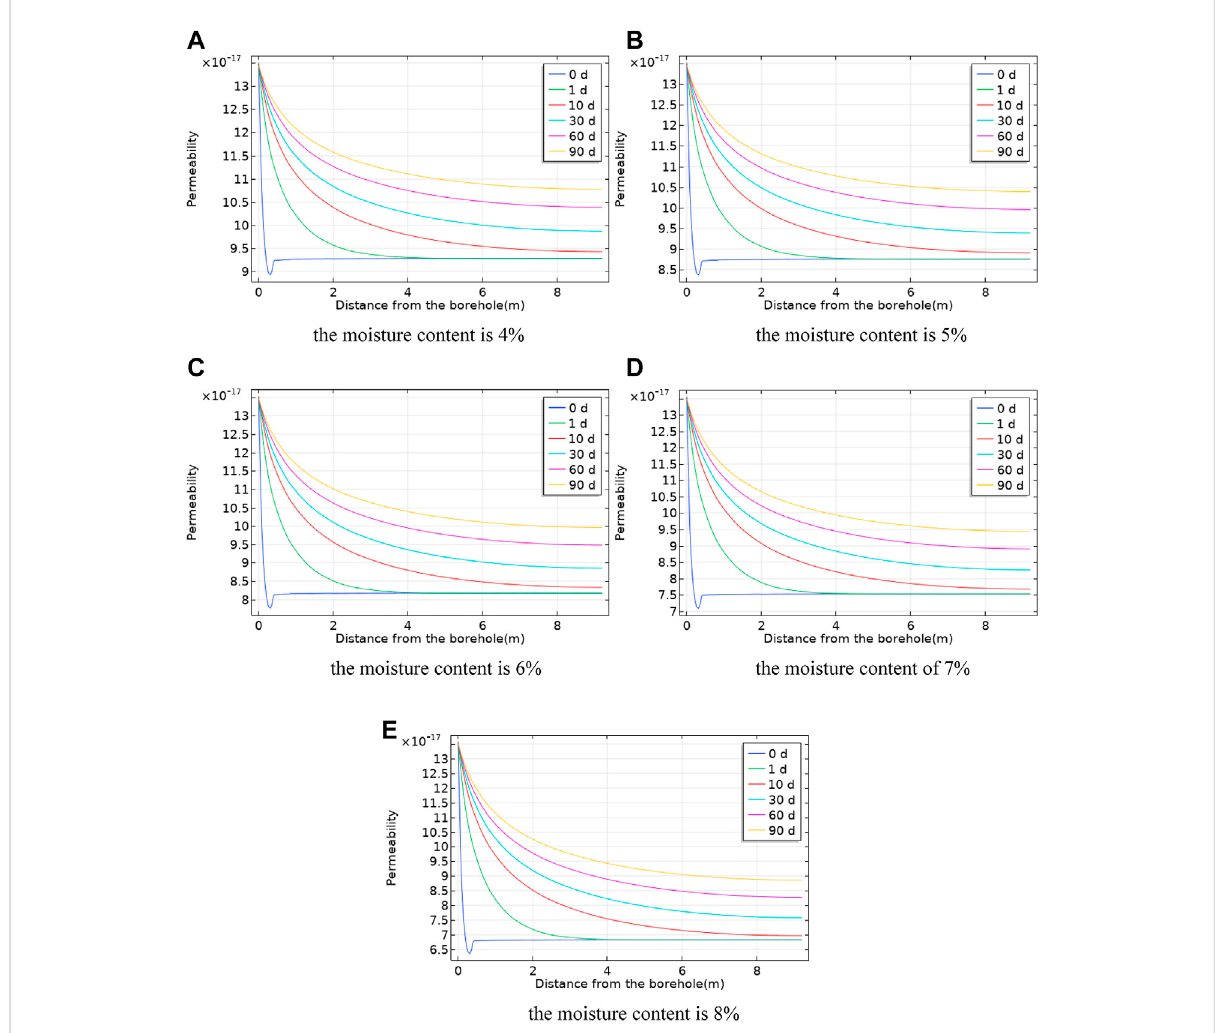
FIGURE 8 Evolution of coal permeability along the short axis of equivalent ellipsoid-like holes under different water content conditions. (A) The moisture content is 4%, (B) the moisture content is 5%, (C) the moisture content is 6%, (D) the moisture content is 7%, and (E) the moisture content is 8%.